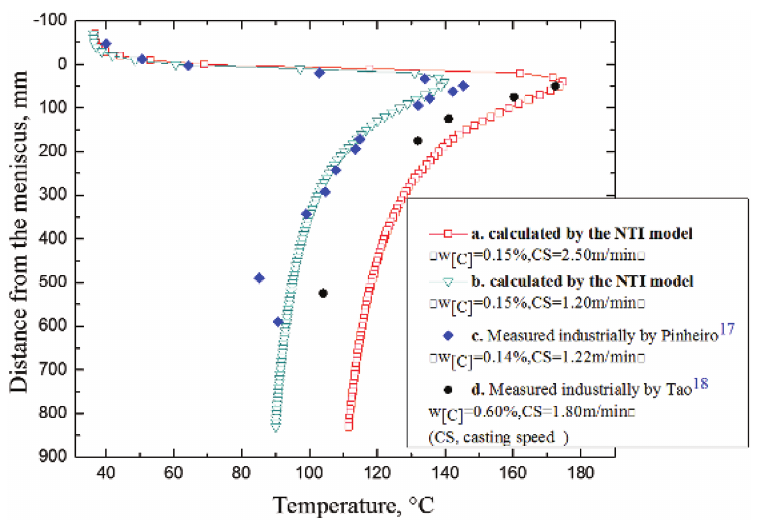
Figure 6: Comparison between calculated temperature and industrially measured data on hot face of mold.